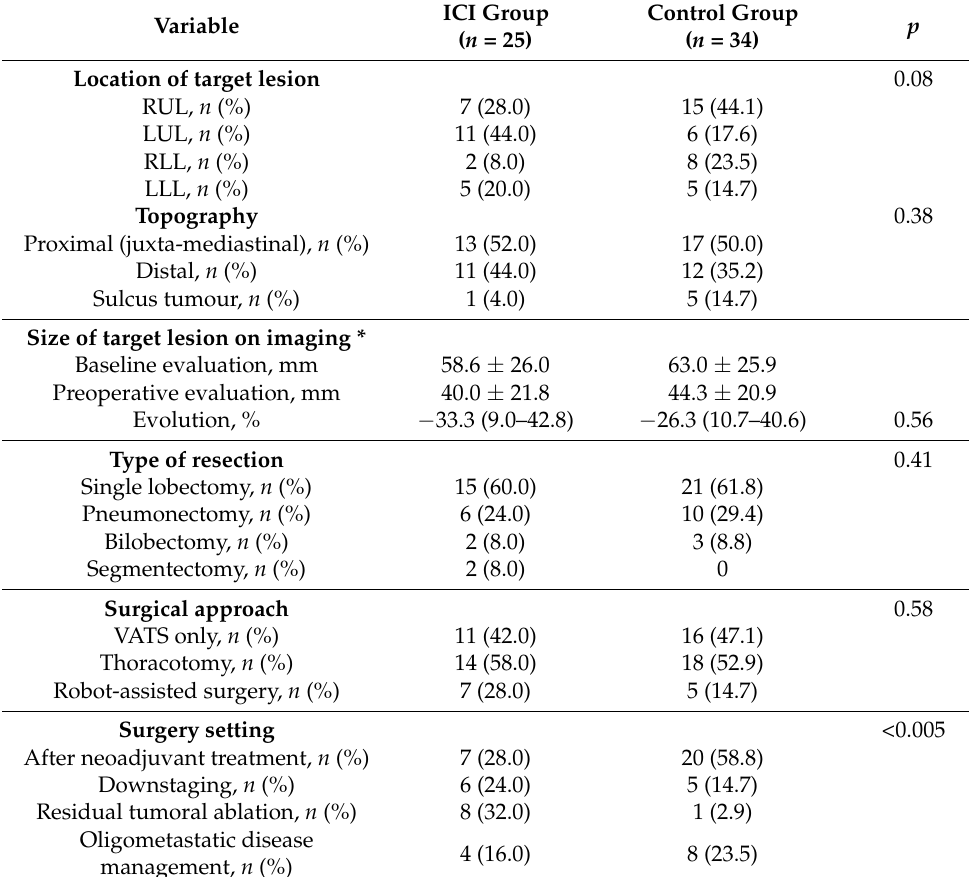
Table 2. Characteristics of surgical